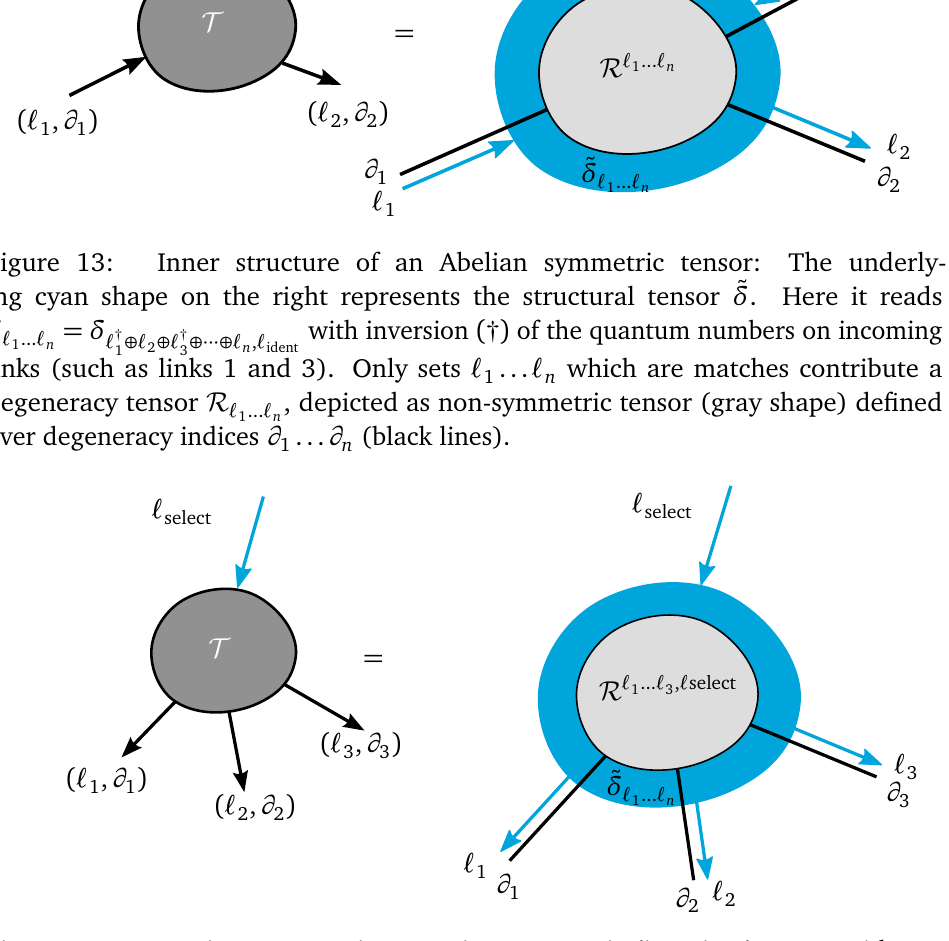
. With this artifice, the structural tensor takes select = δ (cid:96) (cid:96) (cid:96) (cid:96) ⊕ (cid:96) ⊕ (cid:96) ⊕ (cid:96) † , (cid:96) 1 2 3 select 1 2 3 ident select